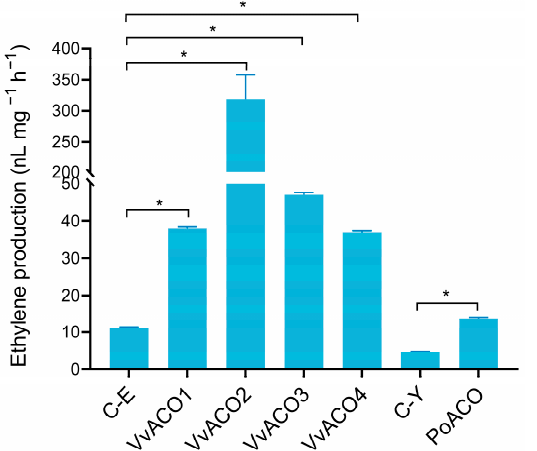
Figure 2. Specific activities of the heterologously expressed ACO enzymes from straw mushroom and oyster mushroom. The data shown were the mean of three independent experiments ± standard deviation (SD). They were analyzed by one-way analysis of variance (ANOVA) followed by the Tukey–Kramer multiple-comparison post hoc test. * Indicates a significant difference at p < 0.05.